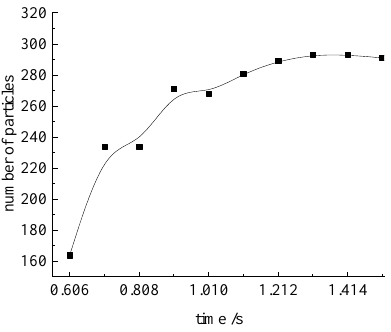
Figure 3. Time independence analysis.